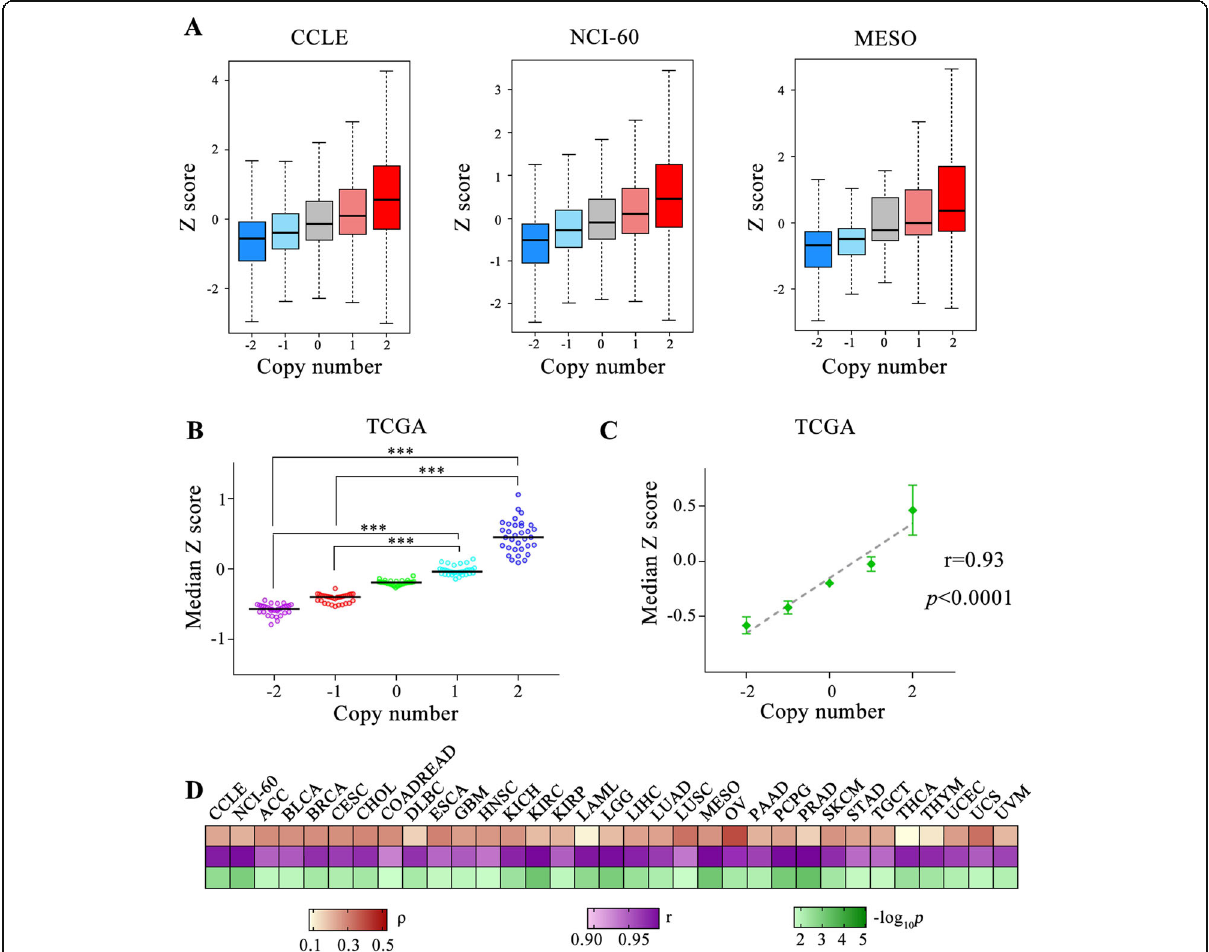
Fig. 1 Integrative analysis of the association between CNV and differential gene expression. a. Boxplots show the relationship of Z score (y-axis) versus copy number value (x-axis) across 966 cell lines for CCLE, 59 cell lines for NCI-60 and 87 tissue samples for MESO. b. Median Z score versus copy number from 31 cancer types was extracted in scatter plot. P values were obtained from a Welch ’ s t-test. *** means p < 0.0001. c. Linear regression analysis of median Z score versus copy number within 31 tumors. d . Heat map shows the ρ between Z scores of gene expression and copy number, Pearson ’ s r of fitting and p value of linear regression analysis on median Z score of gene expression versus copy number among cell lines and tumors. ρ : spearman ’ s correlation